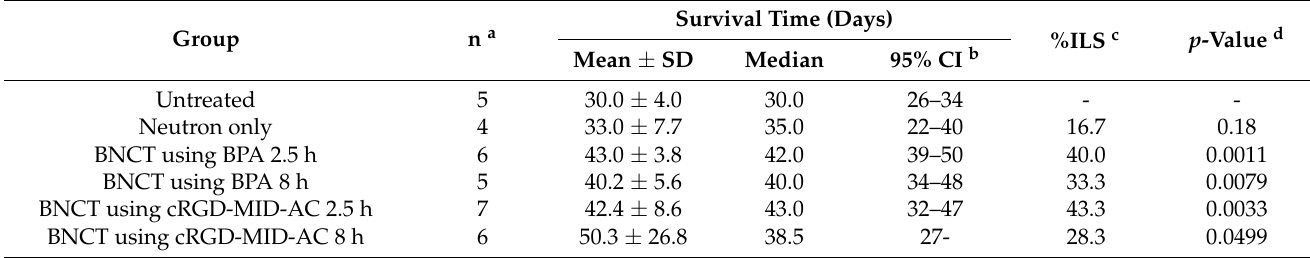
Table 2. Survival times of F98 glioma-bearing rats after neutron